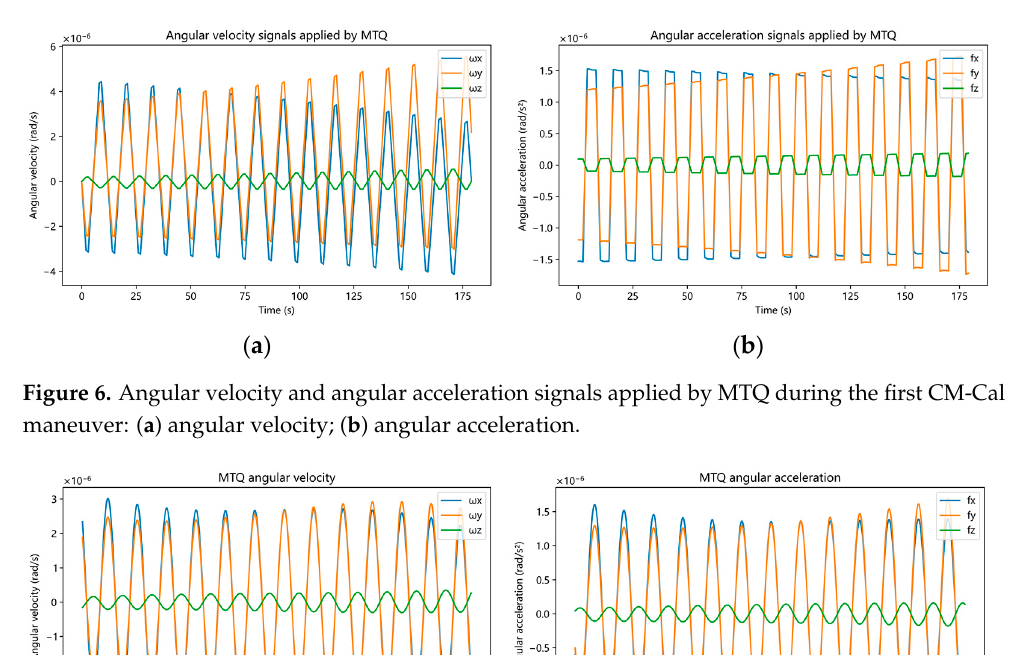
Figure 5. Residual errors sequence of attitude dynamics’ fitting of star camera quaternions: ( a ) the priori residuals of quaternions; ( b ) the posteriori residuals of quaternions.